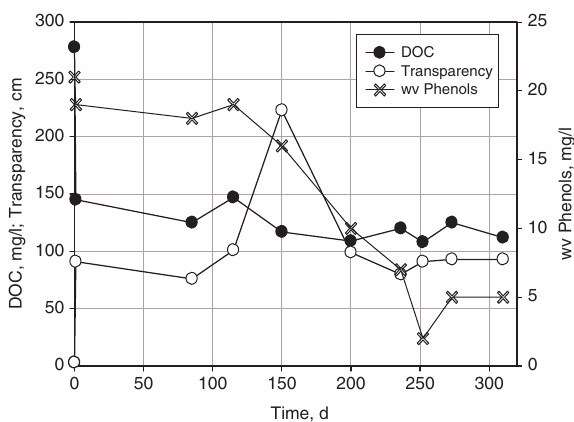
Fig. 6. Dynamics of DOC, watersteam-volatile (wv) phenols and transparency inside the pilot-scale in situ enclosure after flocculation on day zero (14 (cid:31) 15 December 1994) and neutralization on days 80/81 (adapted from Stottmeister et al.